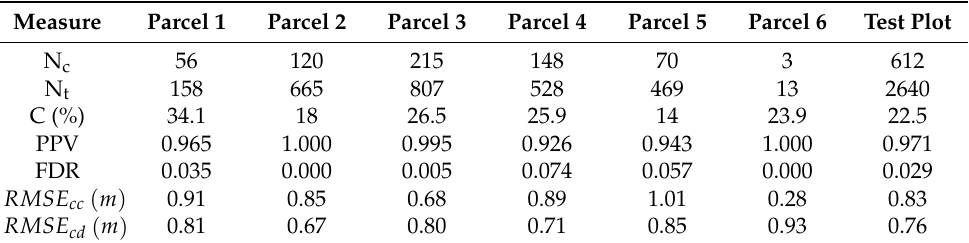
Table 5. Data quality measures results for crowdsourced data about ITC